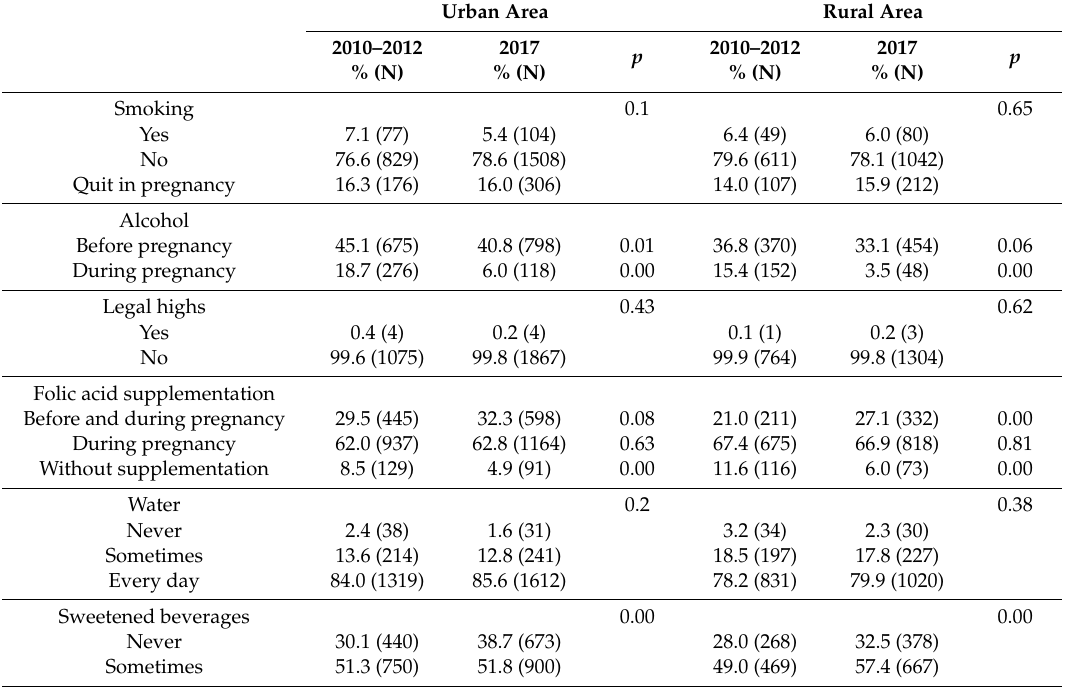
Table 2. Alcohol consumption, stimulant use, folic acid supplementation and consumption of various types of drinks in connection with pregnancy in urban and rural areas in Poland, in the period